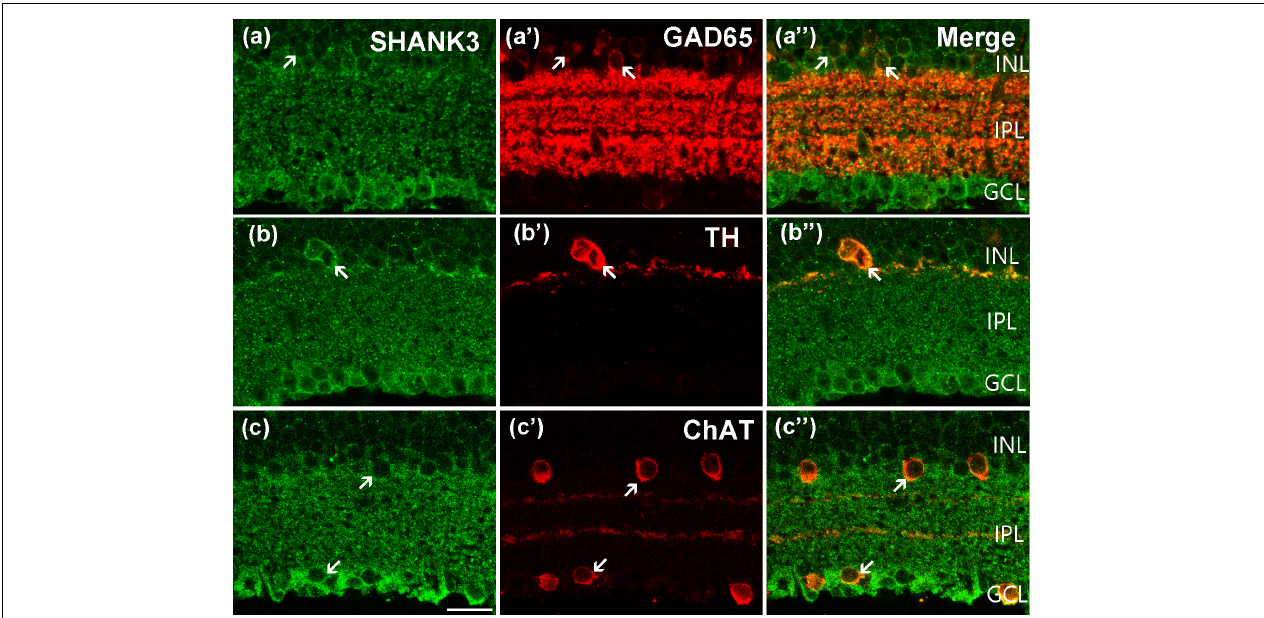
FIGURE 4 | Confocal microphotographs showing the distribution of SHANK3 in different AC subtypes. Double staining (green for SHANK3; red for GAD 65, TH, and ChAT) appear yellowish and arrows indicate some double-labeled cells. (a–a”) Colocalization of SHANK3 with GAD 65 in a retinal vertical section. Fluorescence double stainings show that SHANK3 (a) and the GAD 65 (a’) . Note that the GABAergic ACs in the innermost part of the INL are GAD 65-labeled, and also strongly labeled numerous neuronal processes of these cells in the IPL (a’) . All the GAD 65-positive GABAergic ACs somata are labeled by SHANK3 (a”) . (b–b”) Colocalization of SHANK3 with TH in a retinal vertical section. Fluorescence double stainings show that SHANK3 (b) and the TH (b’) . The soma and processes of the dopaminergic ACs are strongly labeled by TH (b’,b”) , and the soma is clearly labeled by SHANK3 (b”) . (c–c”) Colocalization of SHANK3 with ChAT in a retinal vertical section. Fluorescence double stainings show that SHANK3 (c) and the ChAT (c’) . ChAT-labeled mirror-symmetric cholinergic ACs and their processes, forming two bands in the IPL. The merged image shows that the somata of cholinergic ACs in INL and GCL were both SHANK3-positive (c”) . Scale bar = 20 µ